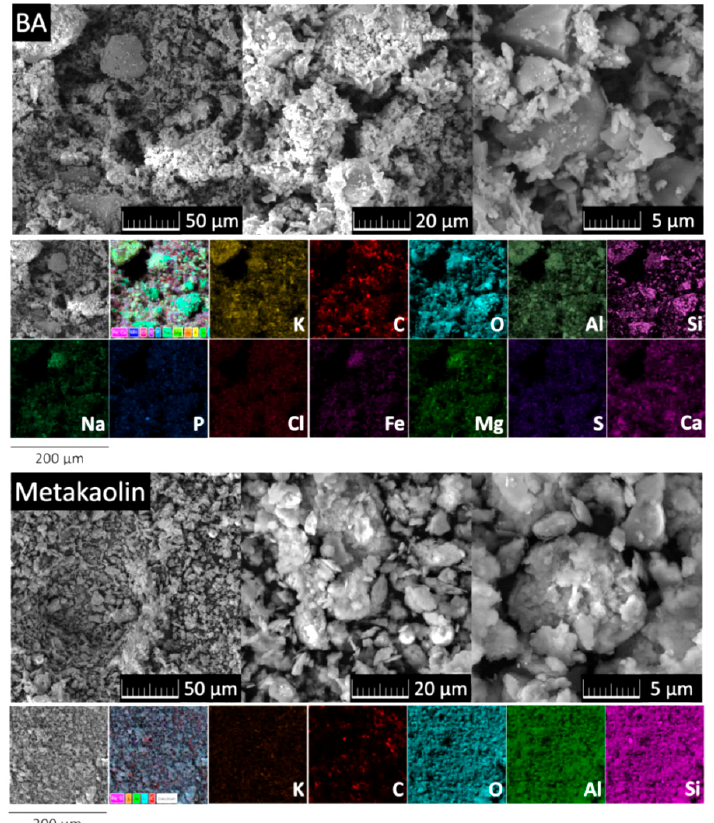
Figure 1. Morphology and elemental distribution maps of BA and metakaolin obtained by scanning electron microscopy energy dispersive spectroscopy (SEM-EDS).